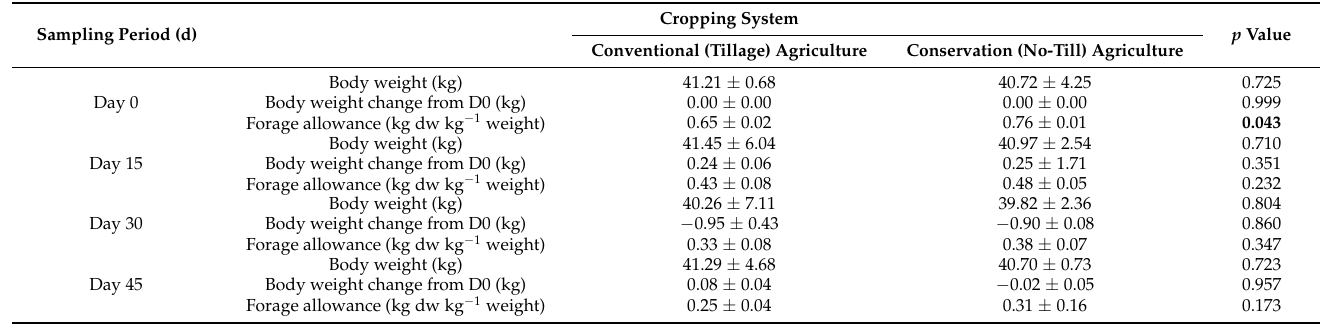
Table 4. Body weight and forage allowance of ewes grazing on the stubble of wheat grown under conventional tillage and no-tillage cropping